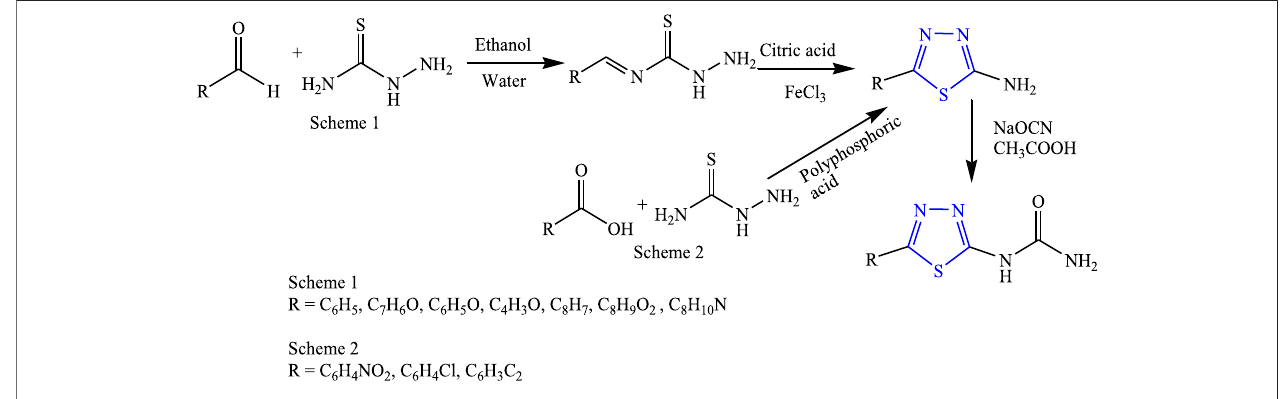
FIGURE 20 | Systematic scheme for synthesizing aryl-substituted 1,3,4-thiadiazole analog.